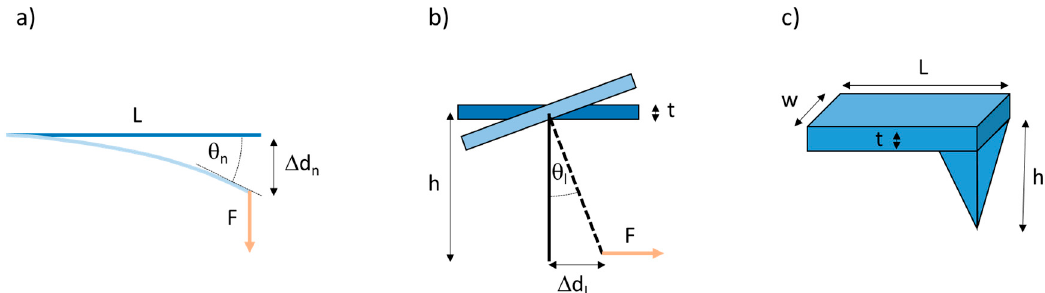
Figure 2. Geometry for normal and lateral atomic force microscopy (AFM) force measurements. ( a ) Side view of cantilever. A normal force applied to an AFM cantilever results in a normal deflection of the cantilever (treated like a flexible beam) by a distance ∆ d n , and a bend angle θ n (measured tangentially at the end of the cantilever). ( b ) Frontal view of cantilever. A lateral force applied to an AFM cantilever results in a lateral deflection of the cantilever by a distance ∆ d l , and a bend angle θ l . This is the situation when pulling on a fiber. ( c ) Schematic diagram of an AFM probe showing the length (L), width (w) and thickness (t) of the cantilever and the height (h) of the AFM tip.